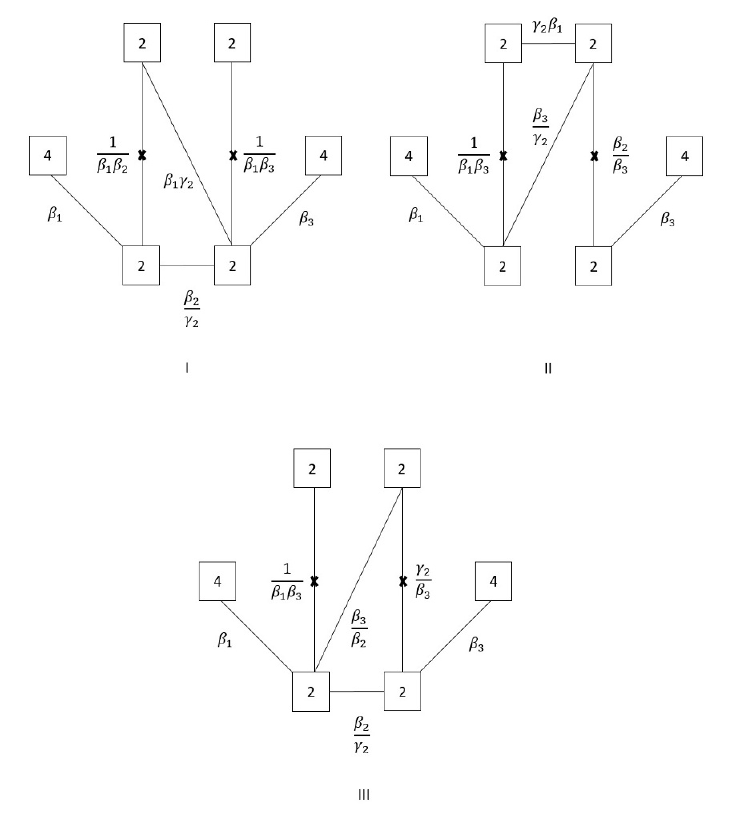
Figure 28 . A collection of tubes in the minimal D 5 case with no (cid:13)ux in the SU(4) (cid:2) SU(4) groups rotating the (cid:13)avors at the ends of the